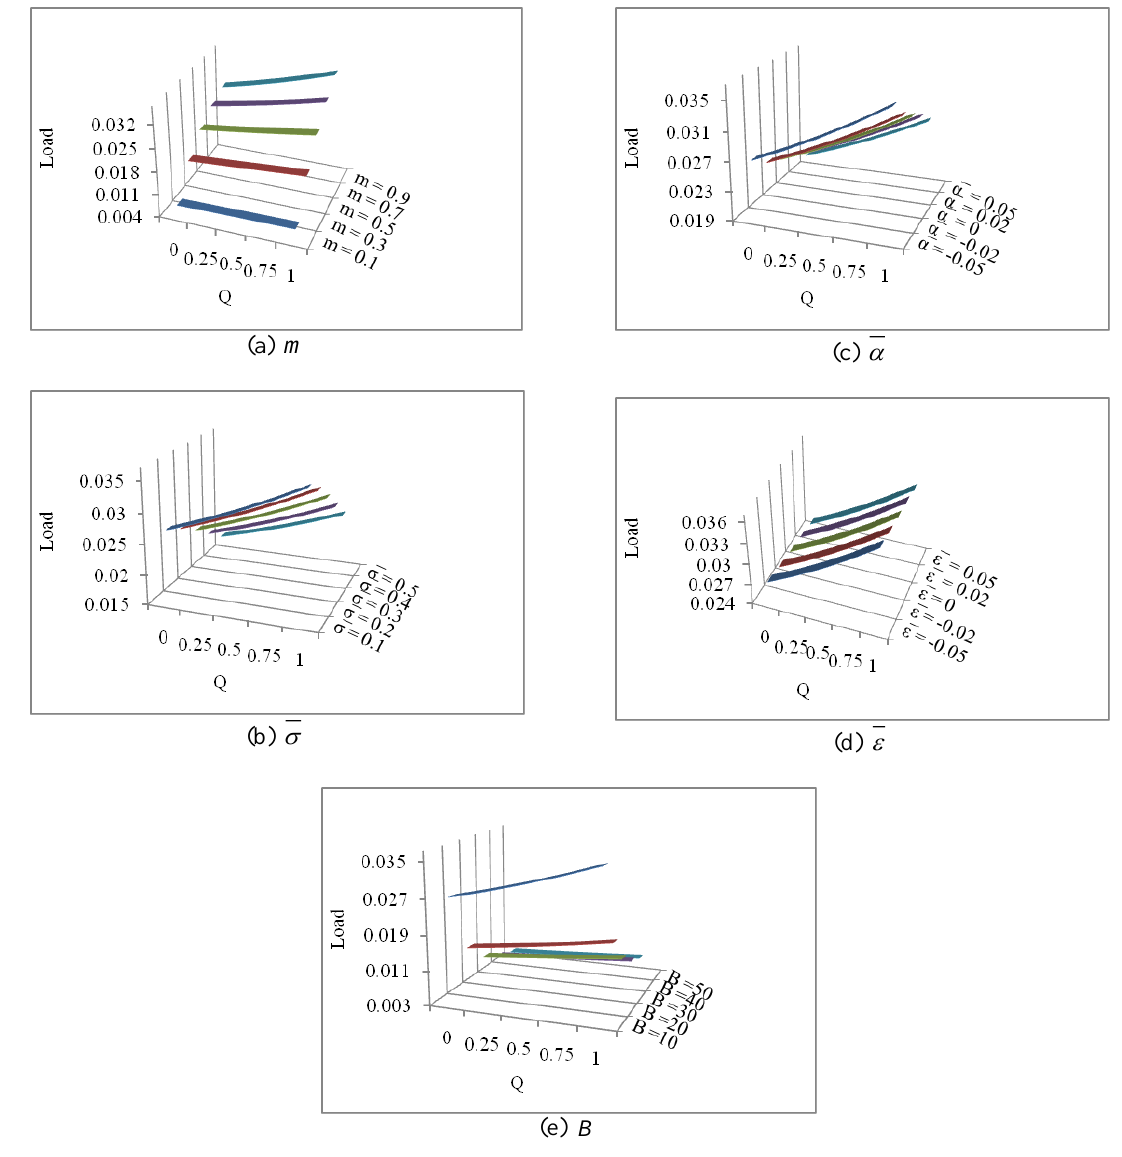
Figure 3. Profile of load bearing capacity with regards to